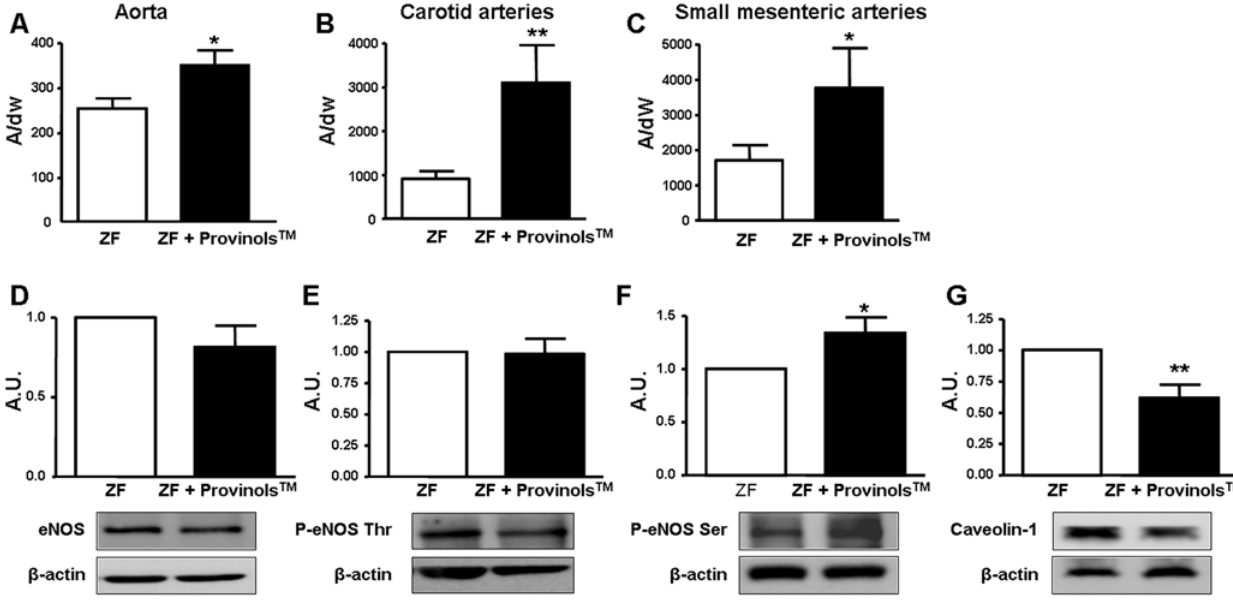
Figure 4. Provinols TM increase NO vascular release in vessels from ZF rats. NO production in aorta (A), carotid arteries (B) and small mesenteric arteries (C) from Zucker fatty (ZF) and ZF + Provinols TM rats. Values are expressed as units of amplitude (A)/mg weight of dried tissue (dw). Western blots revealing expression of eNOS (D), phosphorylation of eNOS at Thr495 (E), and NOS Ser1177 (F) and expression of caveolin-1 (G) in aorta expressed as arbitrary units (A.U.). ( n =6). * P , 0.05, ** P , 0.01 vs. ZF rats.